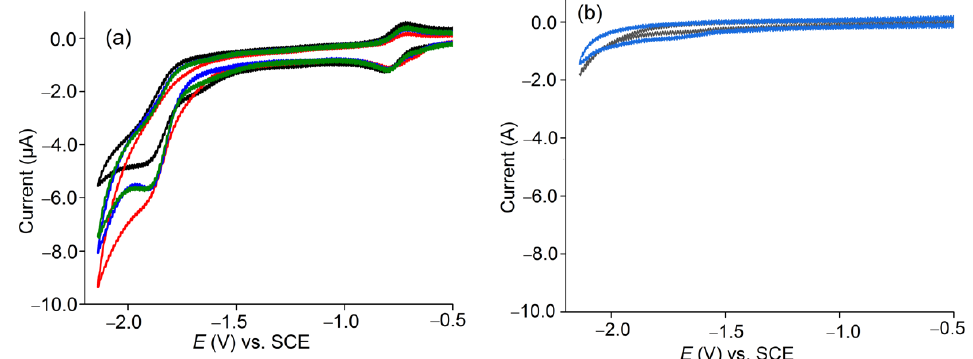
Figure 5. ( a ) Cyclic voltammograms of 1 mM solutions of [Co(TTMPP)] in 0.1 M n- Bu 4 NBF 4 /DMF in the absence of PhOH (black: in Ar, green: in CO 2 ) and in the presence of 1 mM of PhOH (blue: in Ar, red: in CO 2 ). ( b ) Blank test in the absence (black) or presence (blue) of PhOH, without catalyst.